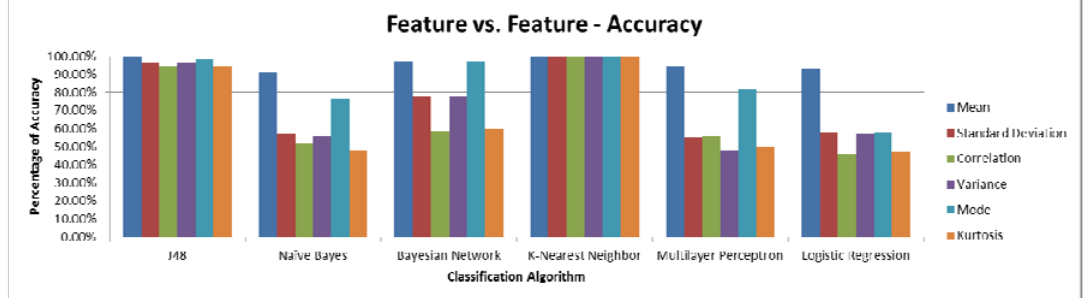
Fig. 3. Feature vs. feature comparison in terms of accuracy